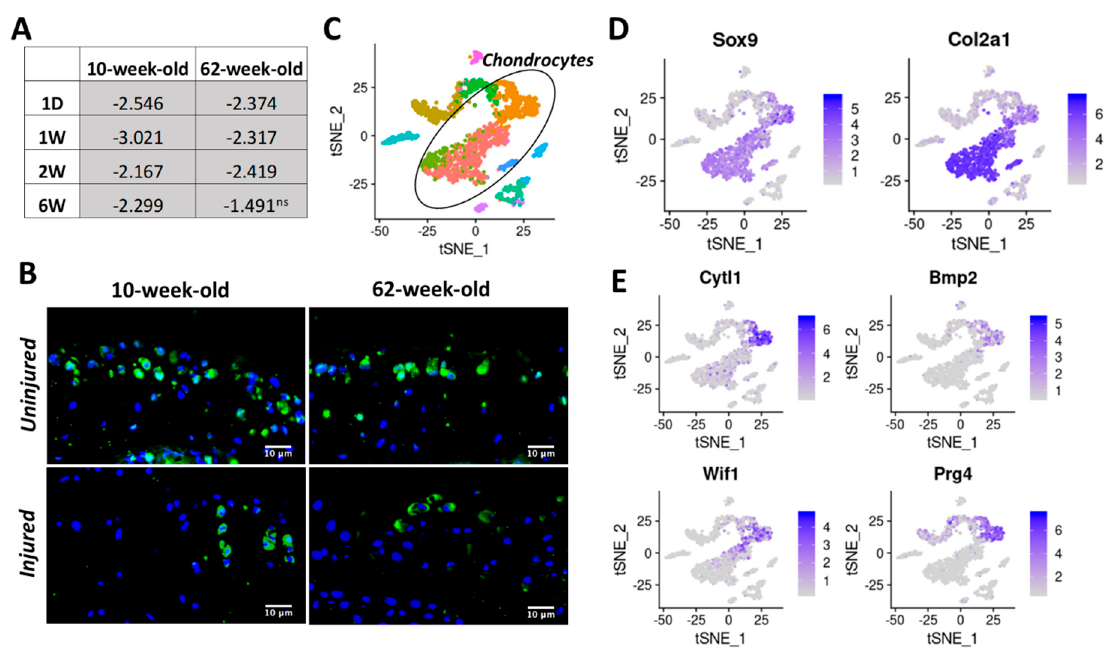
Figure 6. ( A ) Table showing Cytl1 fold down-regulation in injured joints compared with uninjured controls at various post-injury timepoints, in both 10-week-old and 62-week-old mice. ( B ) Cytl1 protein expression at six-week post injury in 10-week-old and 62-week-old mice. Green: protein staining. Blue: DAPI staining marking the nucleus. (40 × magnification) ( C ) tSNE plot of mouse cartilage cells identified using scRNA-seq. Each color represents a distinct cell type / subtype. Chondrocyte subtypes identified in mouse cartilage based on the expression of chondrocyte markers Col2a1 , Acan , and Sox9 are shown in black oval. ( D ) Expression of chondrocyte markers Sox9 and Col2a1 in scRNA-seq data. ( E ) Cytl1 expression is restricted to a chondrocyte subtype that also express high levels of Bmp2 , Wif1 , and Prg4 at high levels. Ns: not significant.